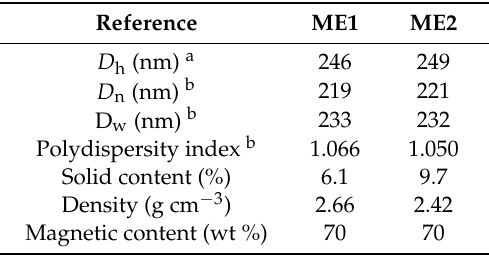
Table 1. Features of the magnetic emulsions